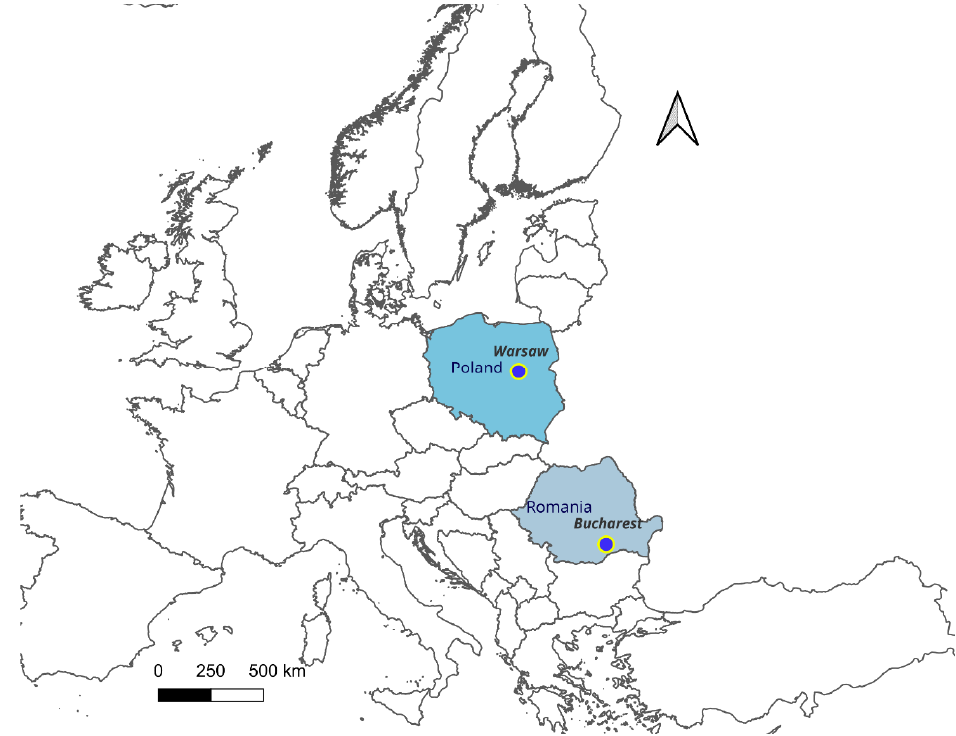
Figure 2. Position of Romania and Poland in a European geographical context. The image shows the capital cities where the case studies are located.